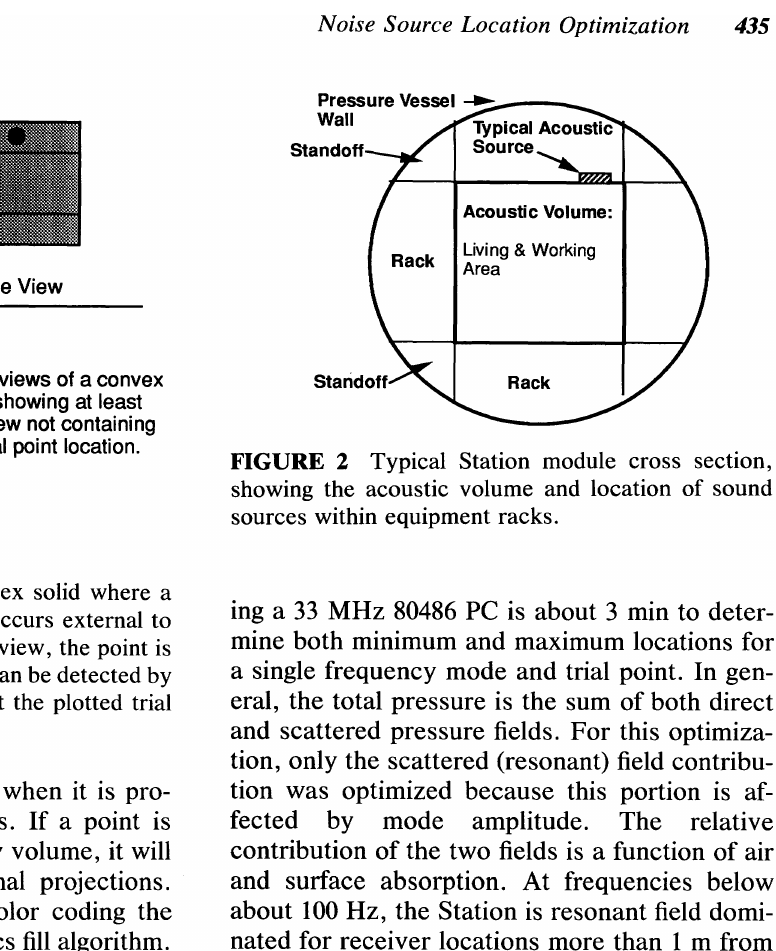
FIGURE 2 Typical Station module cross section, showing the acoustic volume and location of sound sources within equipment racks.